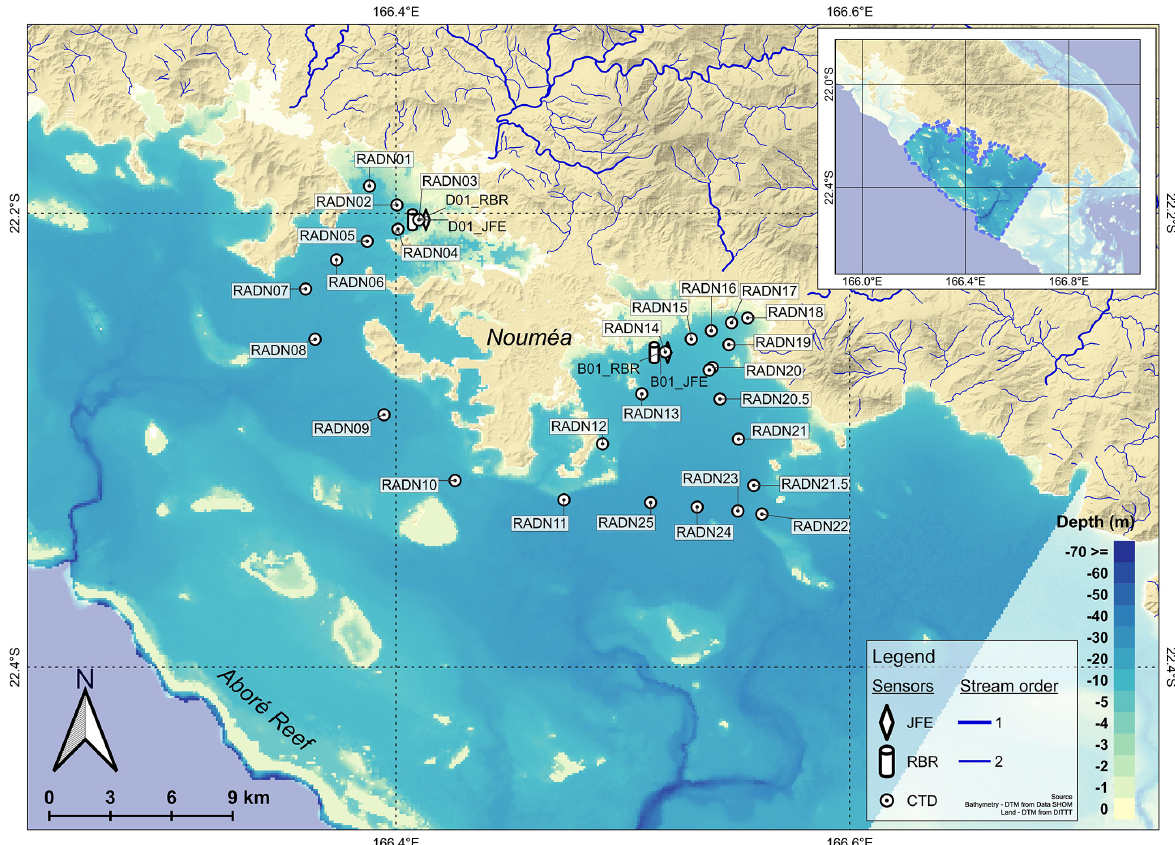
Figure B1. Observational strategy deployed during NOUMEA field experiment. JFE: INFINITY-CTW; RBR: RBRduo T.D or RBRduet T.D; CTD: conductivity – temperature –